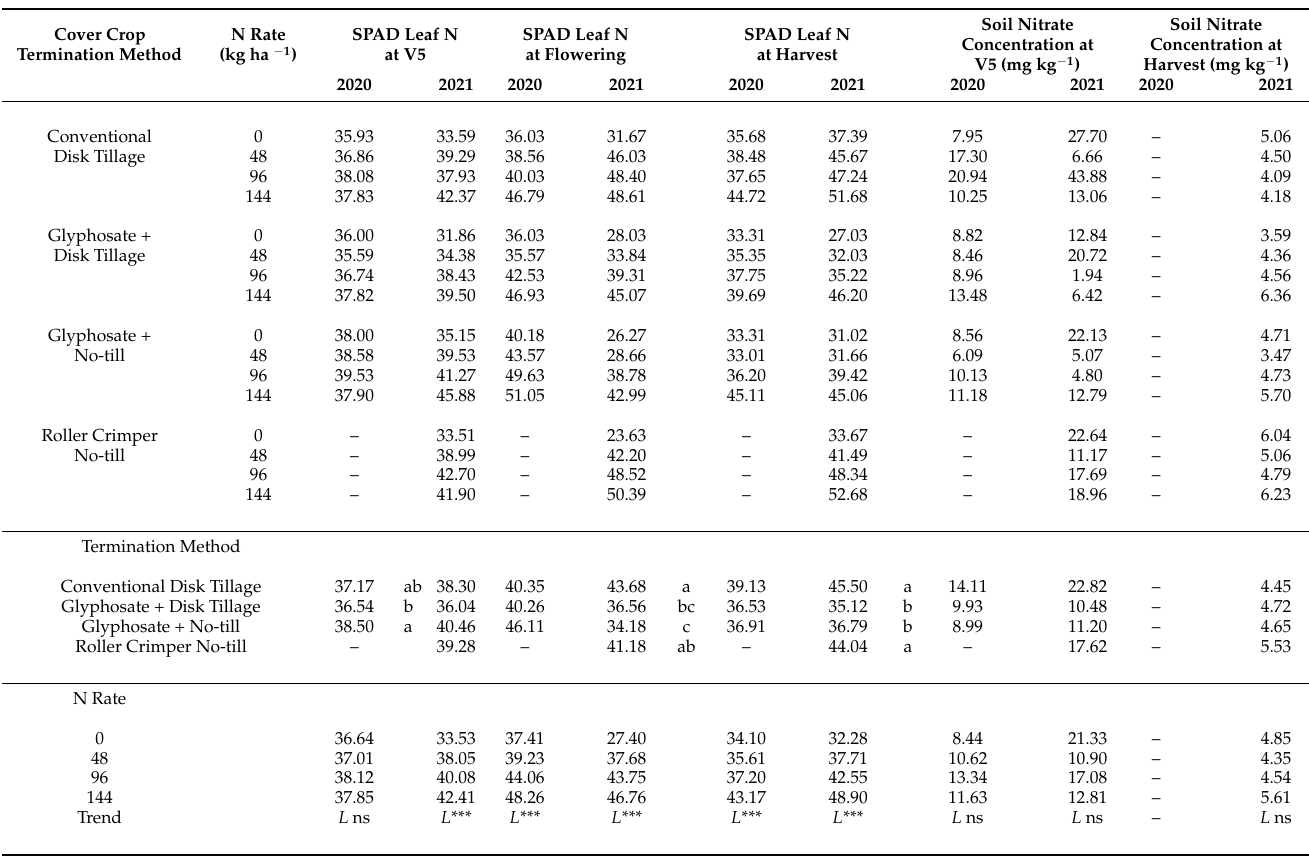
Figure 13. Mean agronomic N use efficiency in sweetcorn as a function of cover crop termination method in 2021. Columns marked with the same letter are not significantly different from each other according to Tukey’s HSD adjusted t tests at p ≤ 0.05. Table 5. Mean sweet corn SPAD leaf N and soil nitrate concentration following different cover crop terminations and N fertilizer rates in South Deerfield,